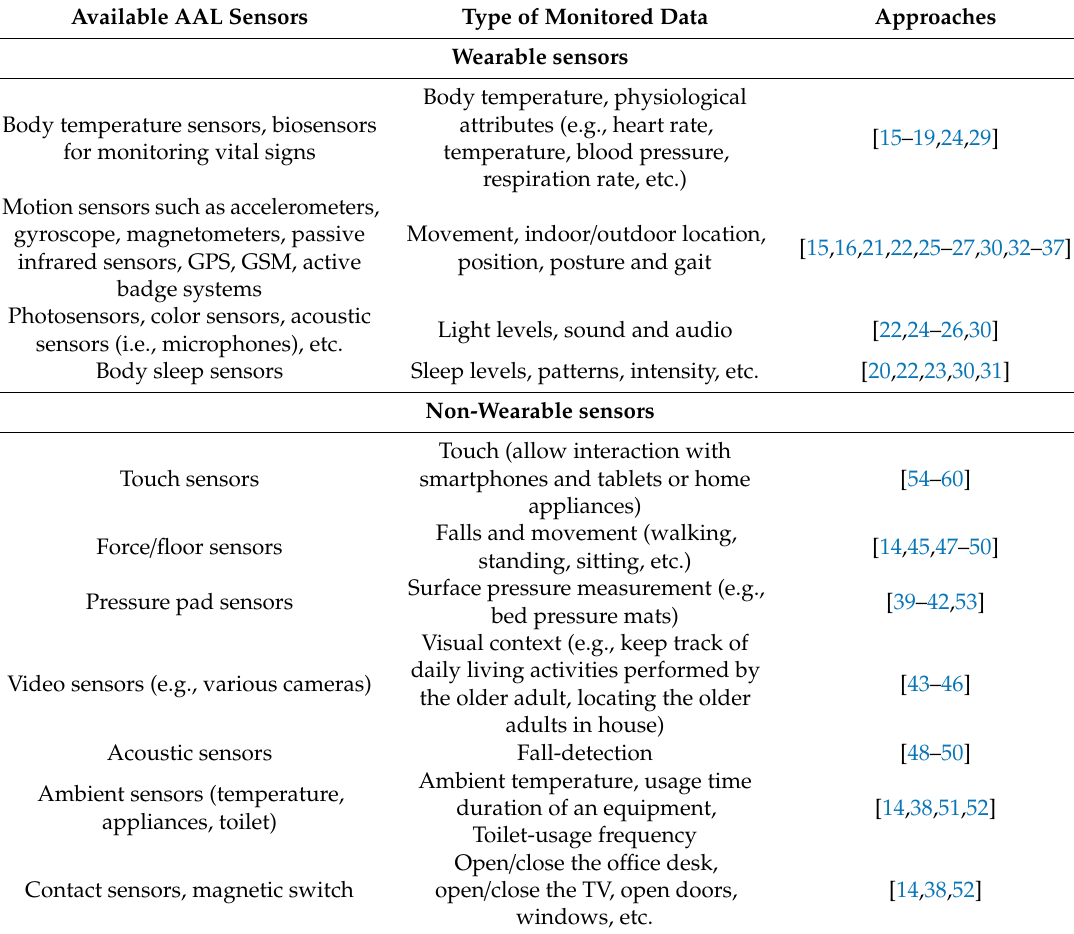
Table 1. Ambient assistive living (AAL) physical sensors and data